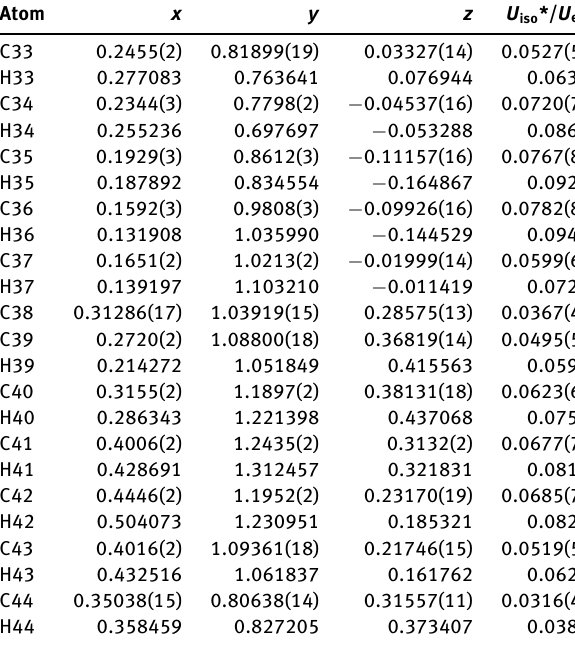
Table 2: Fractional atomic coordinates and isotropic or equivalent isotropic displacement parameters (Å 2